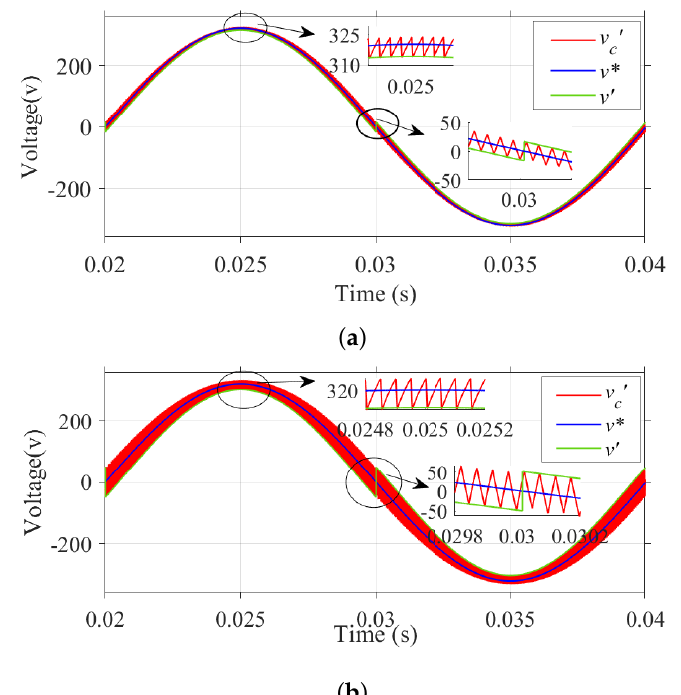
Figure 12. Variable offset correction: Simulated waveforms of v c (cid:48) , v ∗ , and v (cid:48) for different cut-off frequencies. ( a ) f c = 0.5 kHz; ( b ) f c = 1.5